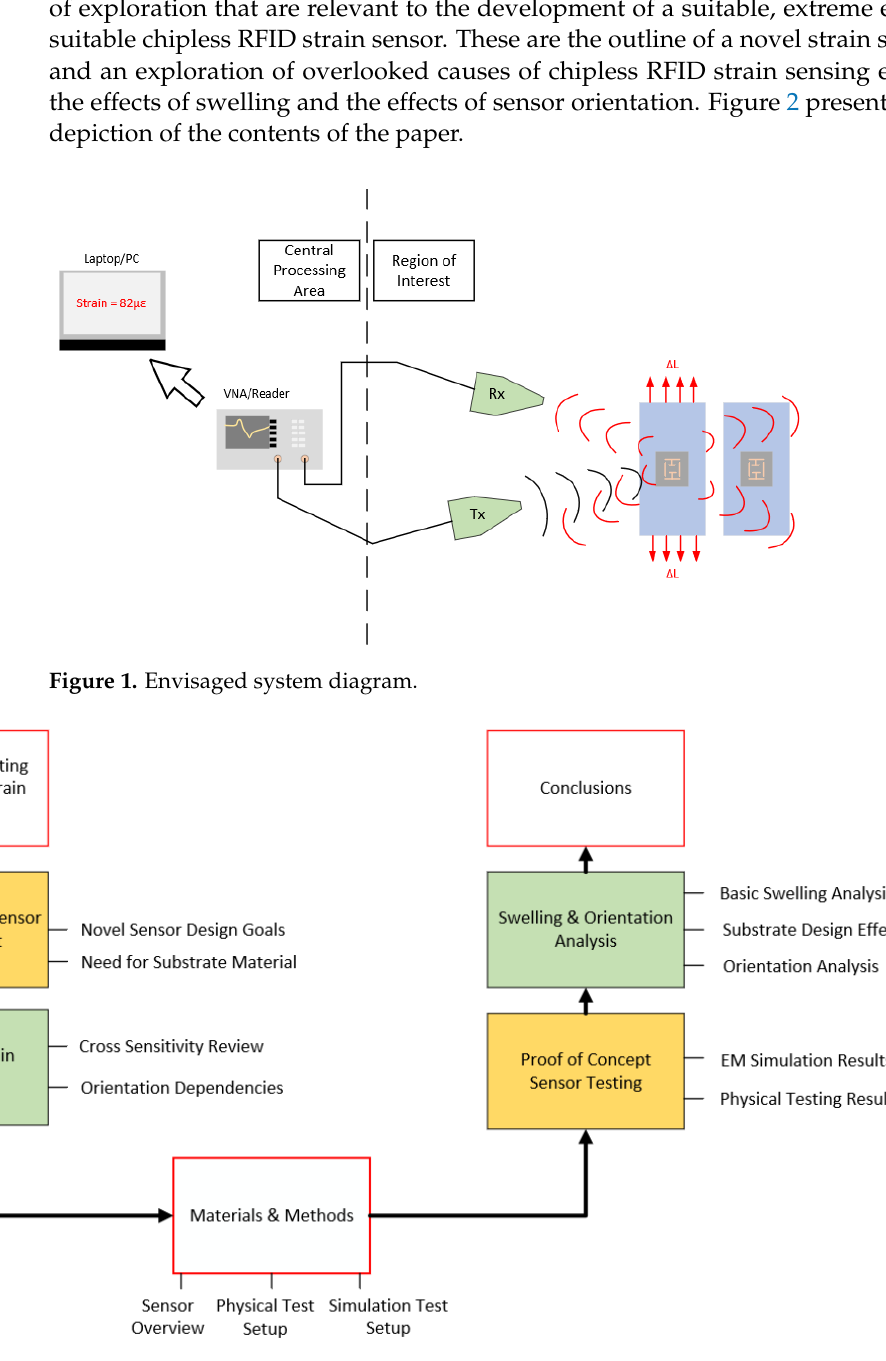
Figure 2. Diagrammatic layout of Paper 1.1. outline of strain sensor development.